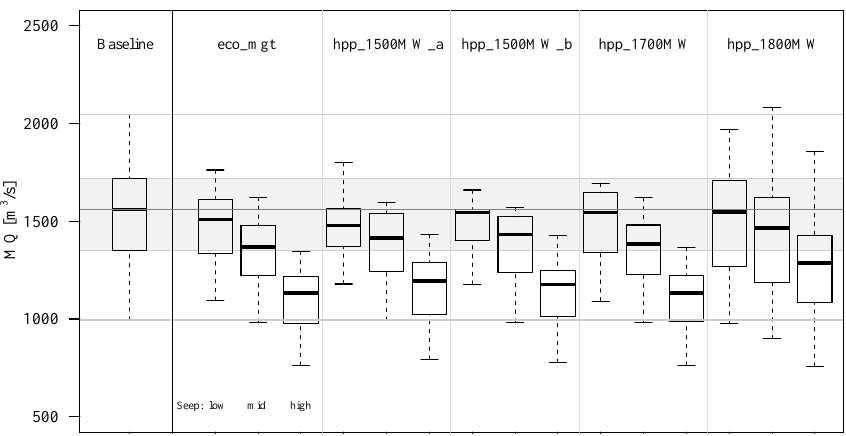
Figure 7. Inter-annual variability of MQ for scenarios with low seepage rates for the period of 1961–1999. Table 3. Reservoir statistics during operation from